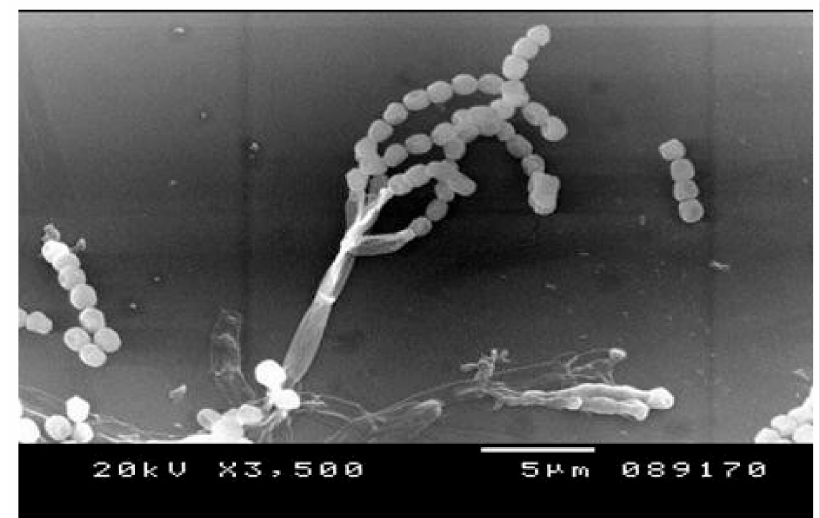
Figure 2. A photo of scanning electron microscope showing the conidia of P. chrysogenum A3 DSM105774. The magnification is × 3500.